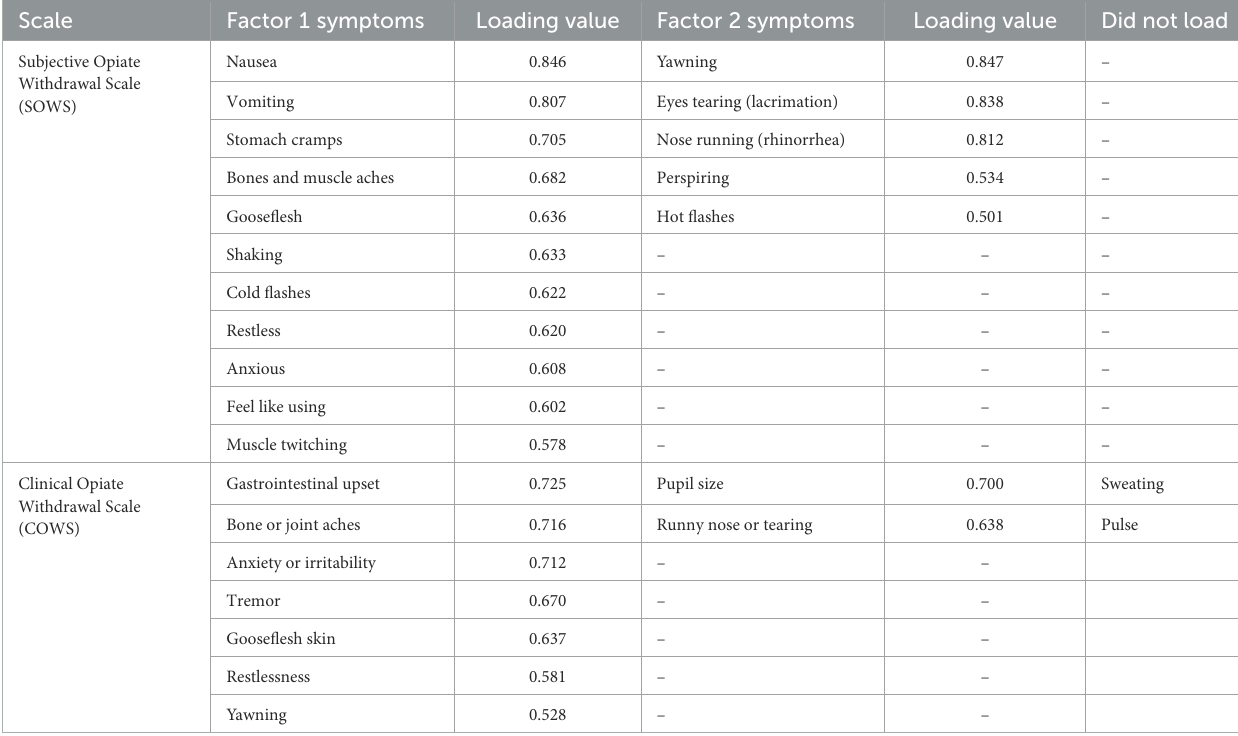
TABLE 2 Peak precipitated withdrawal symptom factors.